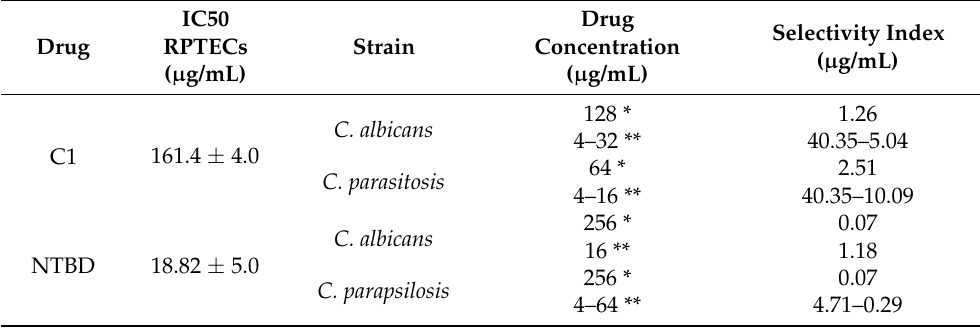
Table 4. IC50 and SI values of tested thiadiazoles (C1 and NTBD); *—MIC of thiadiazole derivatives alone; **—range of thiadiazole derivatives MIC values in the combination with AmB, which exhibited a synergistic effect with the